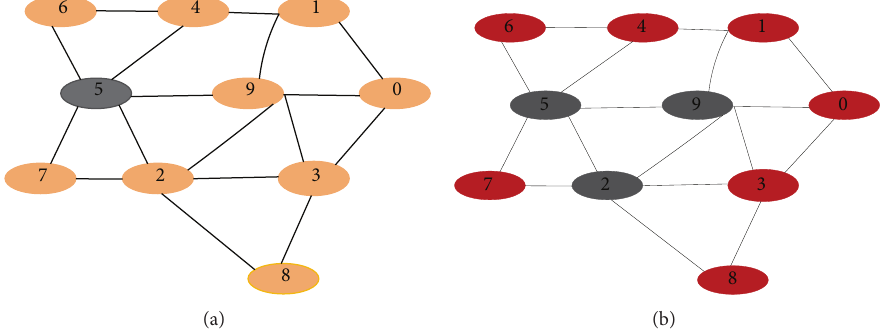
Figure 2: (a) and (b) Disqualify node identification for cluster head selection process (black/whitelist).